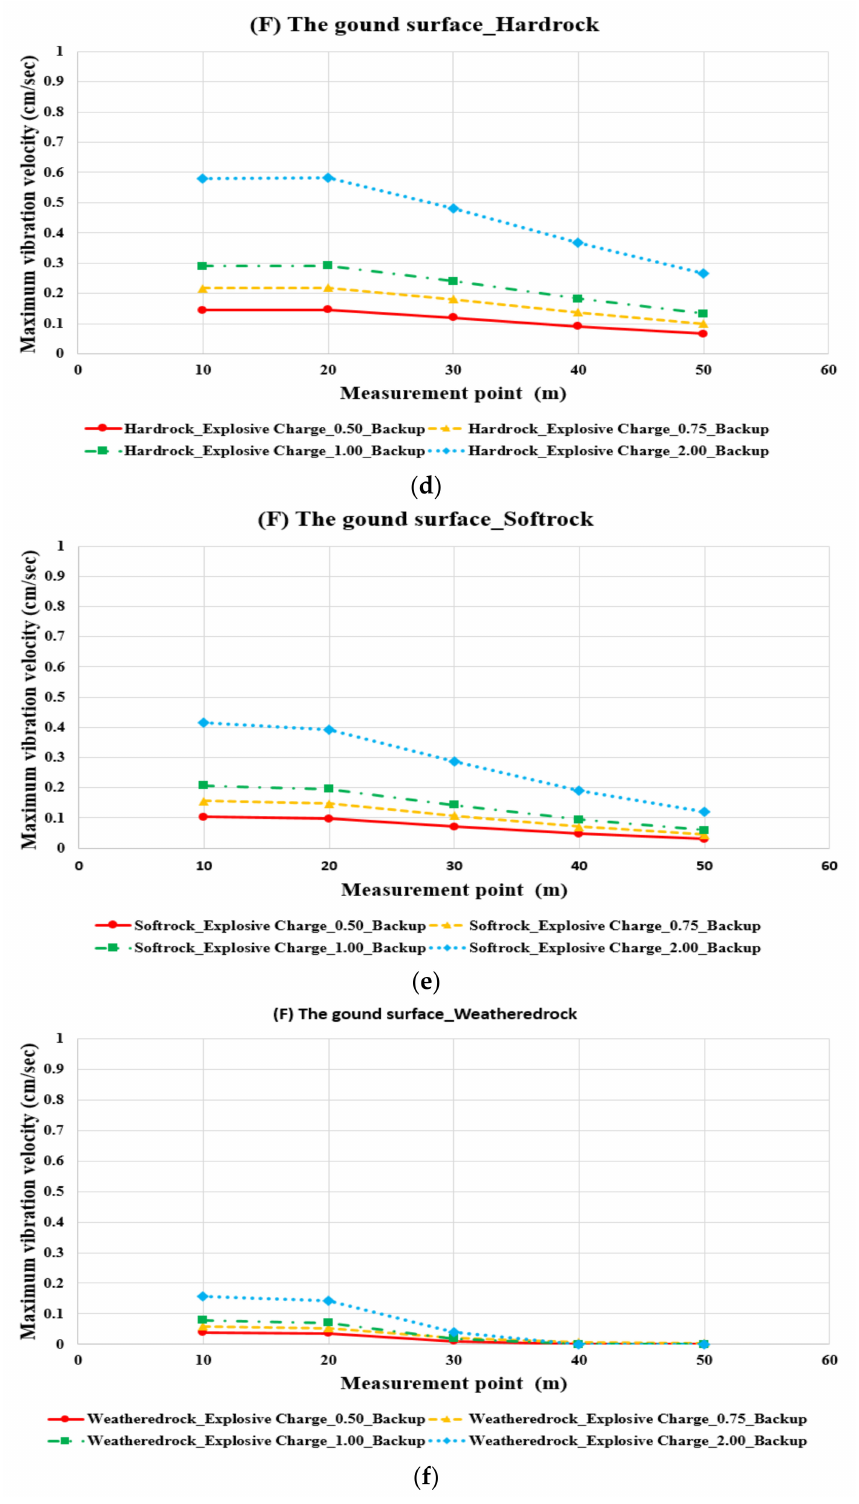
Figure 7. Analysis results for vibration velocity according to type of rock and powder factor (mea- surement points E and F): ( a ) tunnel face (hard rock), ( b ) tunnel face (soft rock), ( c ) tunnel face (weathered rock), ( d ) ground surface (hard rock), ( e ) ground surface (soft rock), ( f ) ground surface (weathered